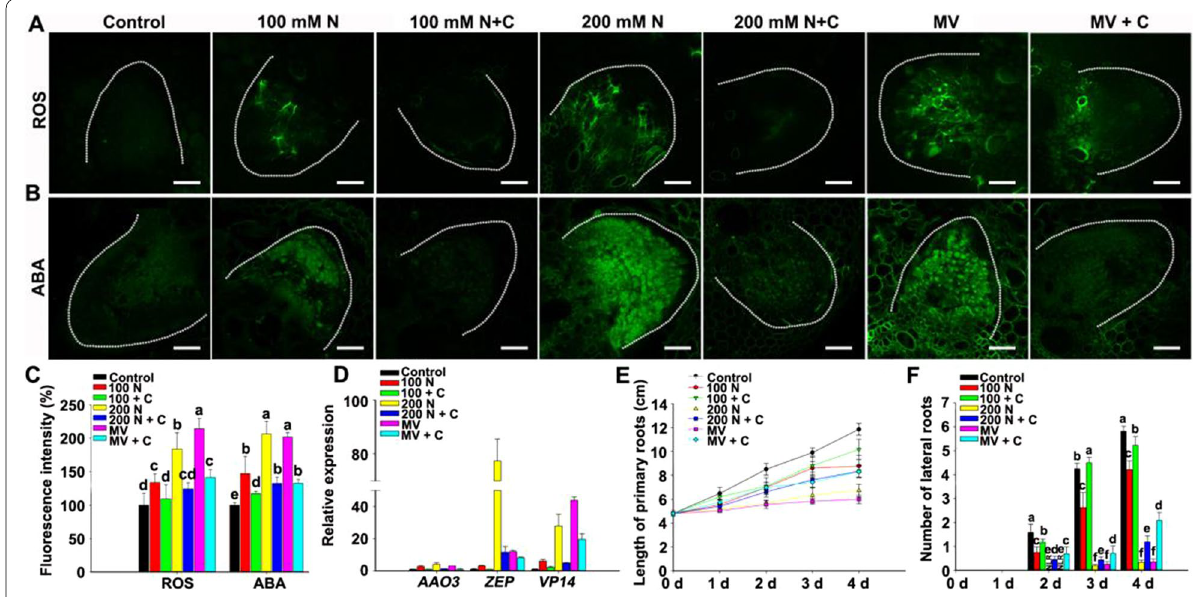
Fig. 1 ROS regulate the accumulation of ABA in lateral roots induced by salt stress. A , B ROS and ABA fluorescence in LRs of 6-d-old seedlings subjected to H 2 O (Control), 100 mM NaCl (N), 100 mM NaCl 100 μM CAT (Catalase), 200 mM NaCl, 200 mM NaCl 100 μM CAT, 10 μM MV + + (Methyl viologen) and 10 μM MV 100 μM CAT for 24 h. ROS and ABA fluorescence were detected by using the fluorescent dye H 2 DCFDA and + immunofluorescence in LRs, respectively. Bar 50 μm. The white thread represents the profile of the LR. C ROS and ABA fluorescence intensity of A = and B. D qRT–PCR analysis of AAO3, ZEP and VP14 expression in maize roots of 6-d-old seedlings subjected to H2O (Control), 100 mM NaCl (N), 100 mM NaCl catalase (CAT, C), 200 mM NaCl, 200 mM NaCl CAT, 10 μM MV (Methyl viologen) and 10 μM MV CAT for 24 h. E Length of PRs after + + + different treatments for 4 d. PRs is from independent maize seedling ( n 6). F Number of LRs ( n 6) after different treatments for 4 d. LRs is from ≥ ≥ independent maize seedling (